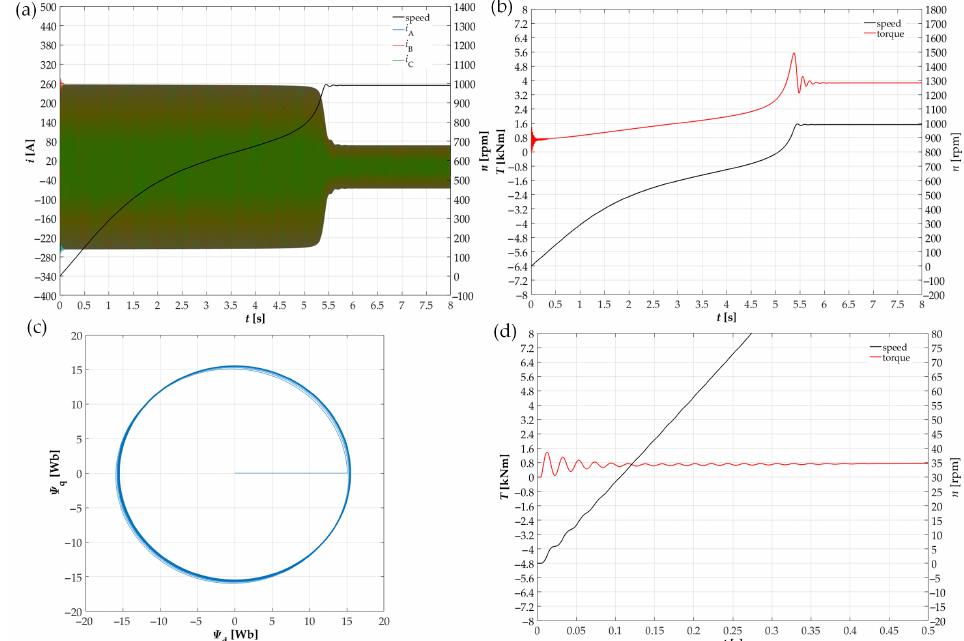
Figure 12. Waveforms of physical quantities for direct starting, with a voltage phase switching delay of t delay = 5 ms and a fan load moment T o = 3859 three phases and rotational speed; ( b ) time course of electromagnetic torque and speed rotational speed; ( c ) hodograph of stator fluxes; ( d ) fragment of the electromagnetic torque and rotational speed temporal waveform, in the first moment of